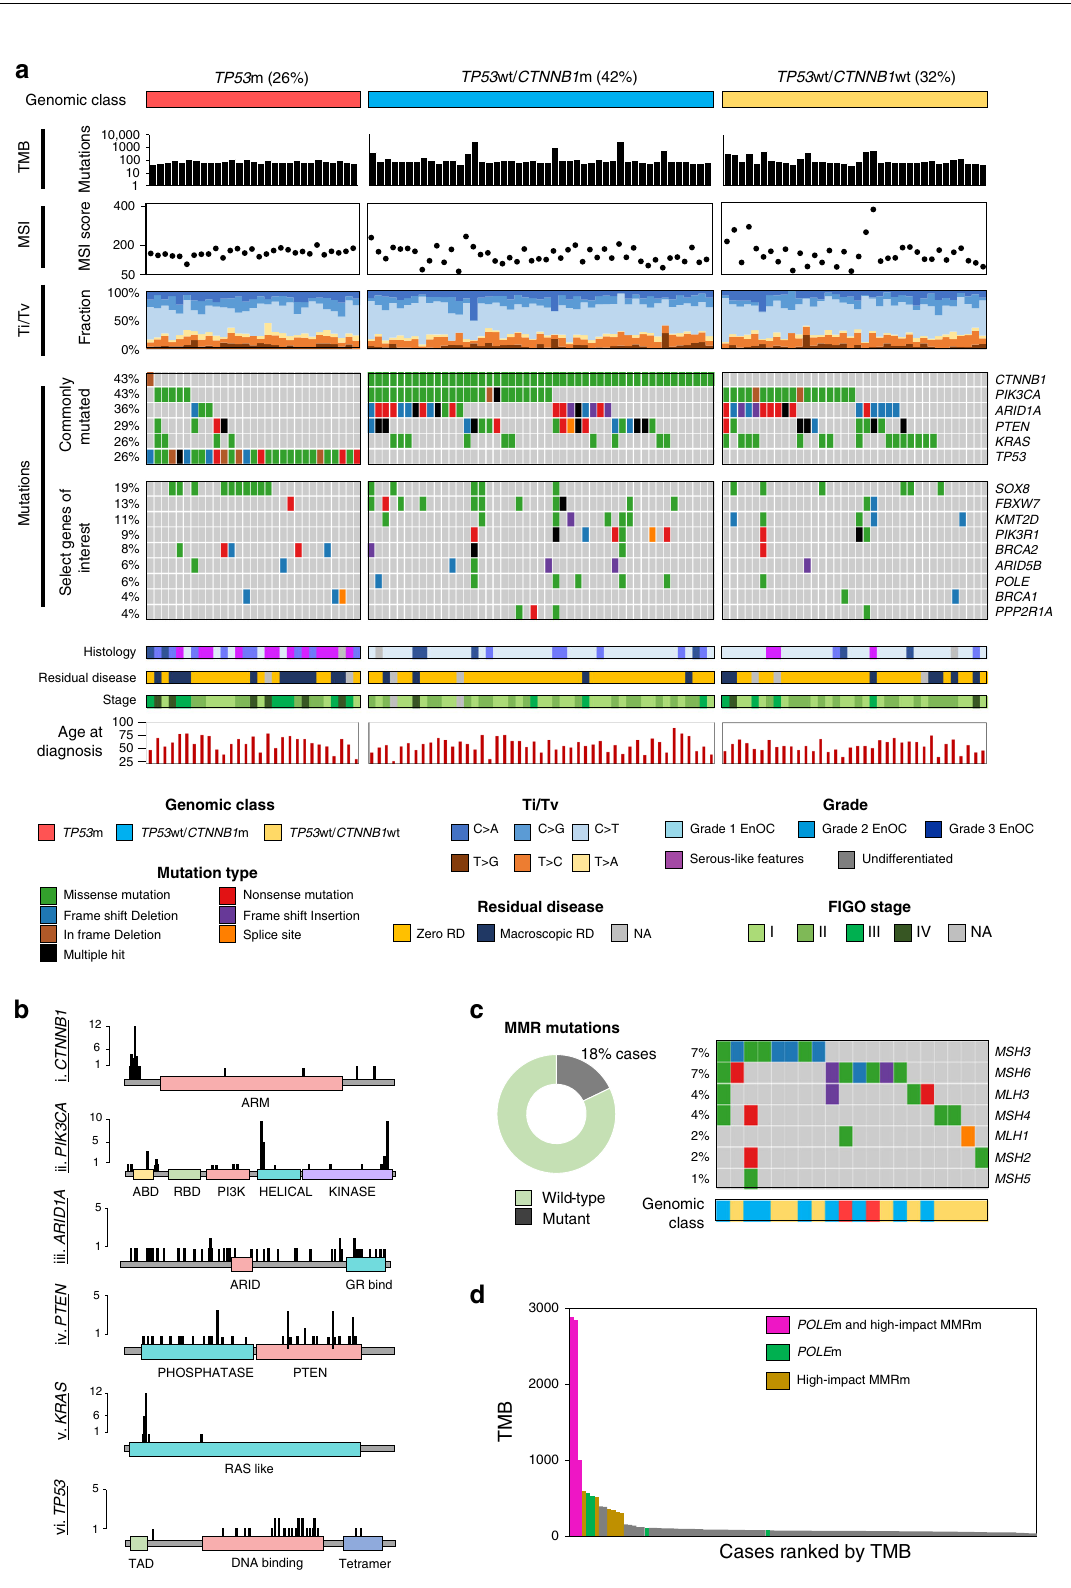
Fig. 3 Genomic characterisation of endometrioid ovarian carcinoma (EnOC). a Whole exome sequencing identi fi es three major genomic subtypes of endometrioid ovarian carcinoma based on TP53 and CTNNB1 mutation status. Molecular signatures for each tumour are plotted as the fraction of transversions and transitions. Mutations are displayed as an oncoplot. Grey denotes no mutation. Upper plot shows the six most frequently mutated genes; lower plot shows select genes of interest. b Lollipop plots of fi ve common gene targets of mutation. c Mismatch repair (MMR) mutations across cases. d Relationship between tumour mutational burden (TMB) and mutations in POLE and/or MMR genes. Ti transition, tv transversion, MSI microsatellite instability, RD residual